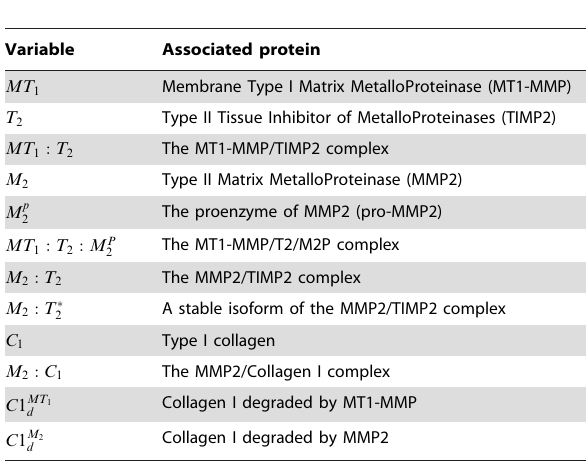
Table 1. The variables names in the model and corresponding